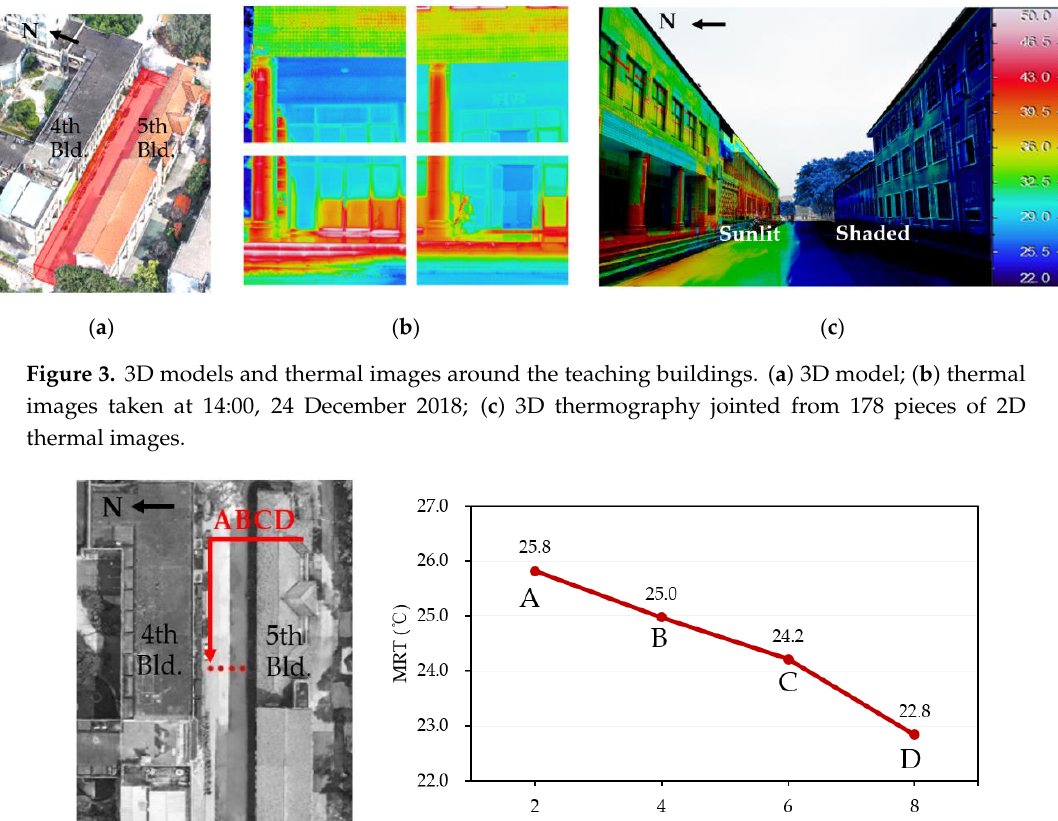
Figure 3. 3D models and thermal images around the teaching buildings. ( a ) 3D model; ( b ) thermal images taken at 14:00, 24 December 2018; ( c ) 3D thermography jointed from 178 pieces of 2D thermal images.